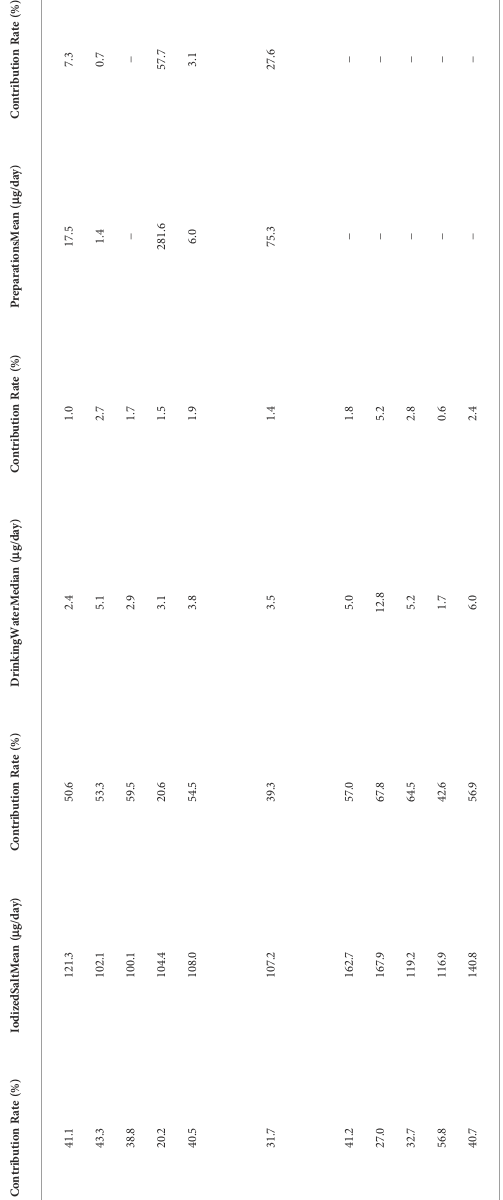
(Figure 6A); Fujian had the highest percentage of 85.54%. In